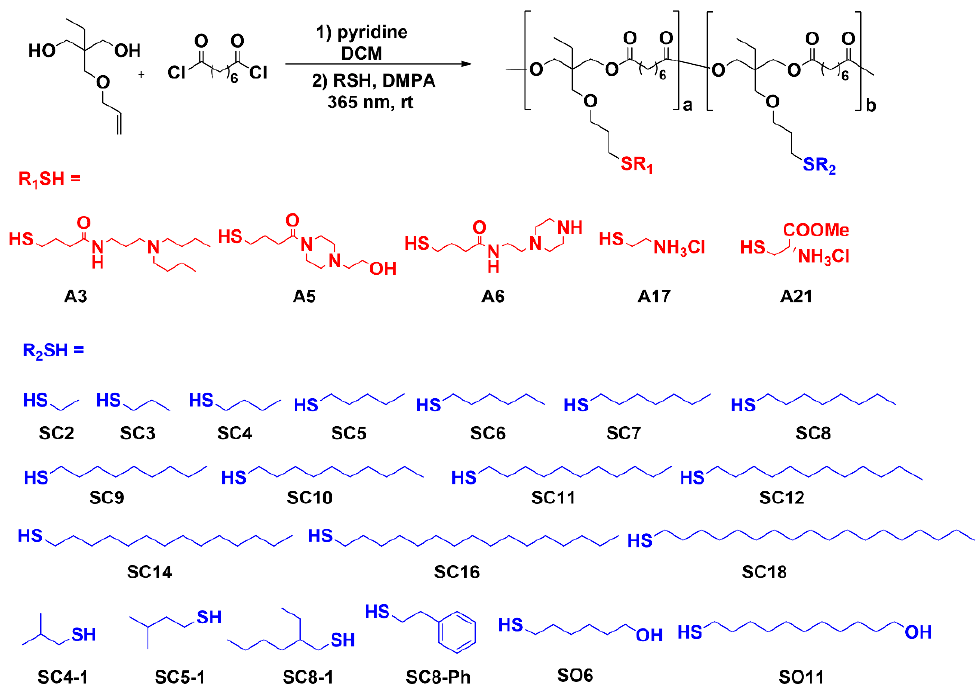
Figure 1. A combinatorial library of functional polyester NPs was screened in IGROV1 cells to optimize mRNA delivery materials. A library of 1200 functional polyesters was chemically synthesized for the screening of mRNA delivery. Polyesters were modified with amino thiols (R 1 SH) and alkyl thiols (R 2 SH) to generate a combinatorial polymer library. Amino thiols are named A followed by a number; alkyl thiols are named SC or SO followed by the number of carbons. Functional polyesters with Mw 4200 g/mol (PE4K), 8300 g/mol (PE8K), and 17,000 g/mol (PE17K) were modified with five amino thiols ( A3 , A5 , A6 , A17 , and A21 ) and all 20 alkyl thiols at SC:A molar feed ratios of 1:4, 1:2, 1:1, and 2:1. Functionalized polymers are named by the polyester Mw , amino modification, and the mole fraction of alkyl modification. All functional polyesters were examined for in vitro mRNA delivery efficacy. Selected functional polyesters (0.2C4 to 0.2C11; 0.3C5 to 0.3C9) were examined for in vivo mRNA delivery efficacy.